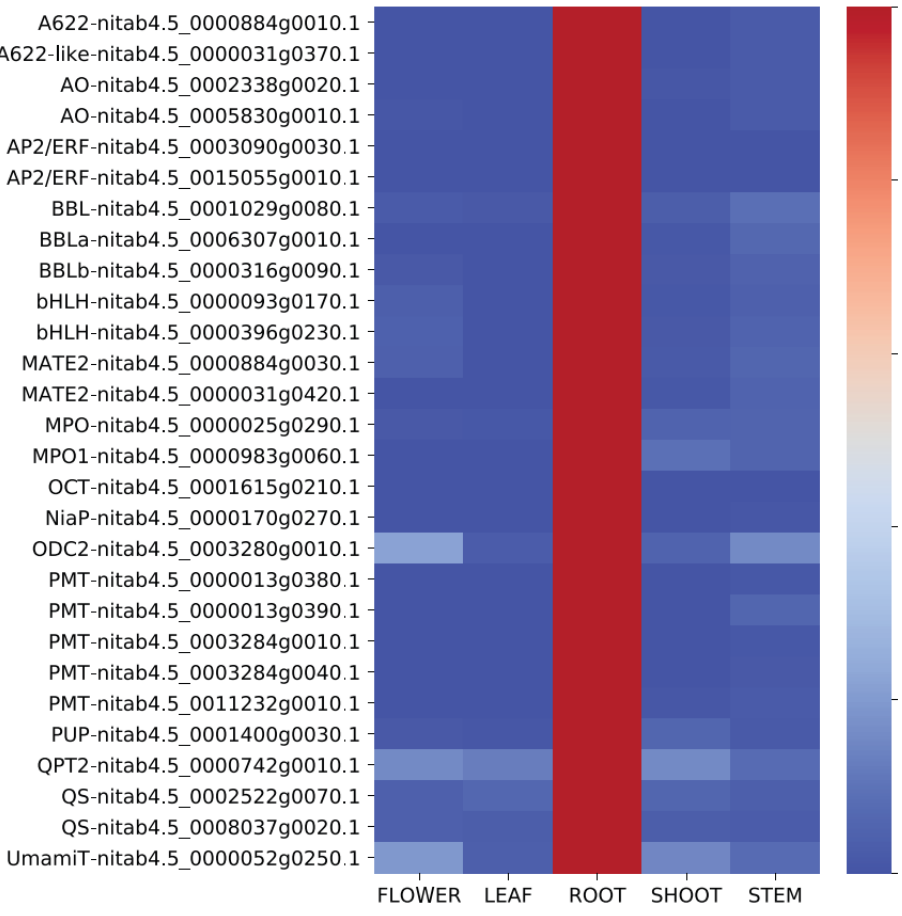
Figure 4. Relative expression of genes across major organs in Nicotiana tabacum . The expression values for each gene were scaled by dividing each row by the maximum value found in the row.